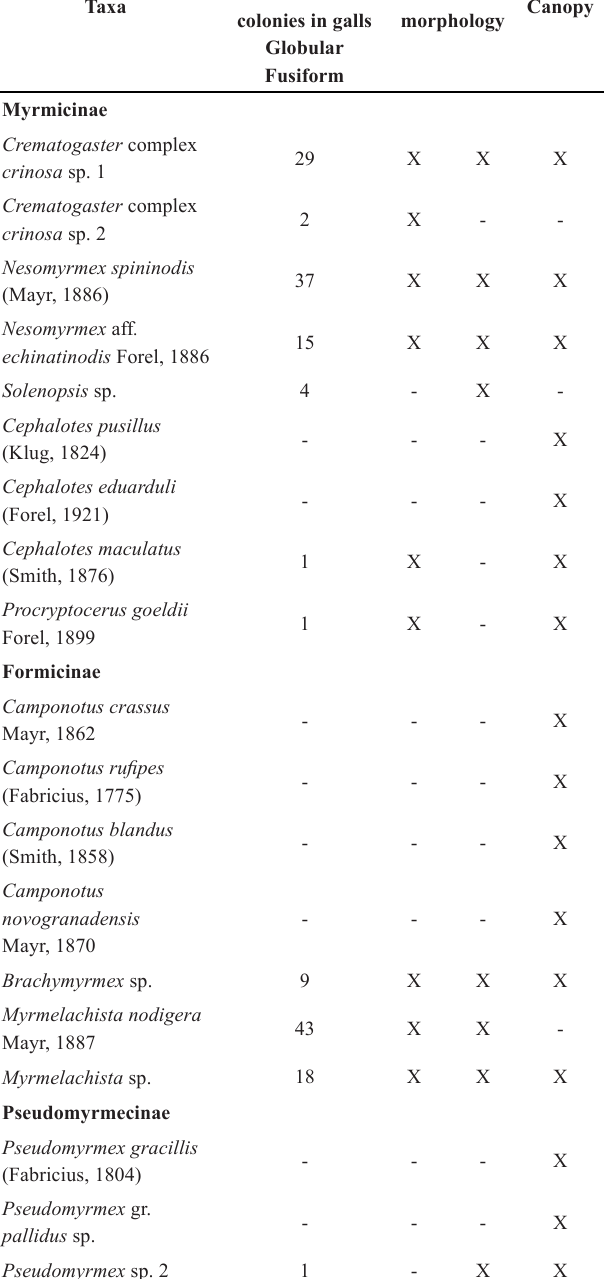
1887) (Myrmicinae), with 37; and Crematogaster complex crinosa sp. 1 (Myrmicinae) with 29 colonies (Table 1). Table 1 . Ant species found in senescent stem-galls and canopy of E. erythropappus from the study sites . “X” means presence and “-“ means